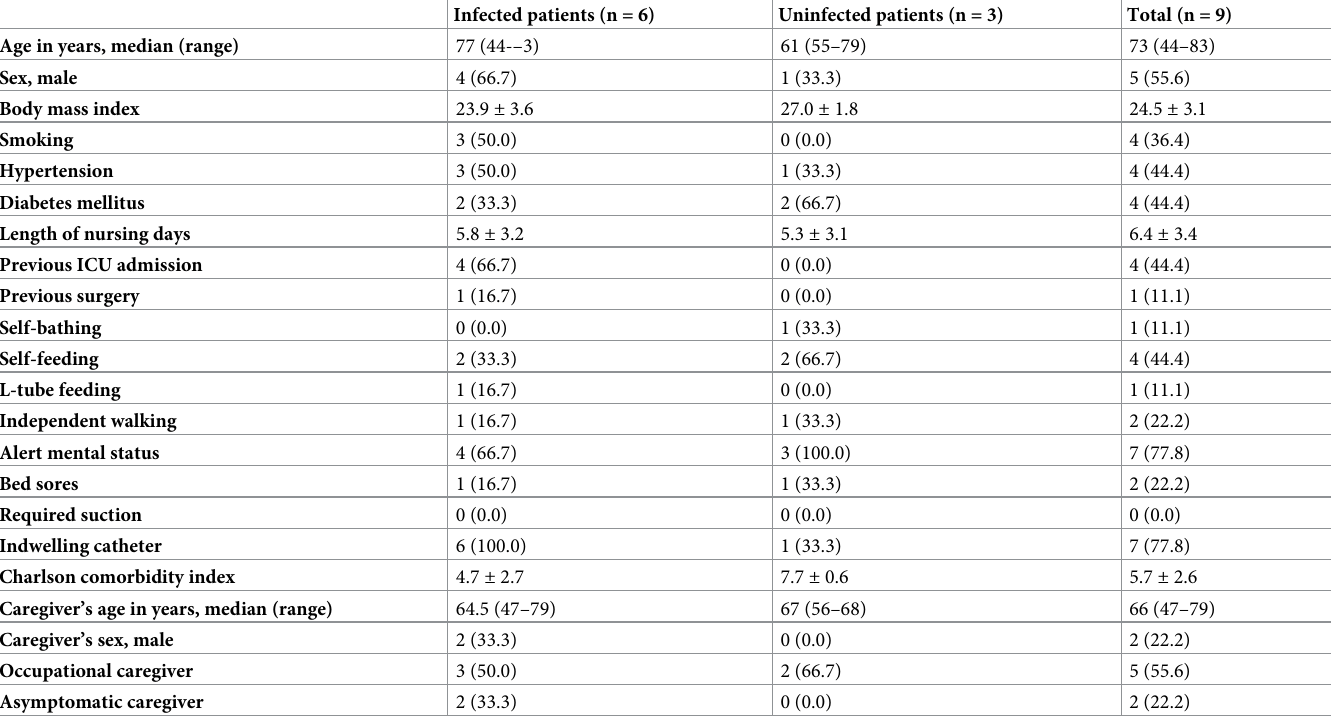
Table 2. Comparisons of infected and uninfected patients exposed to their own COVID-19-positive caregivers.